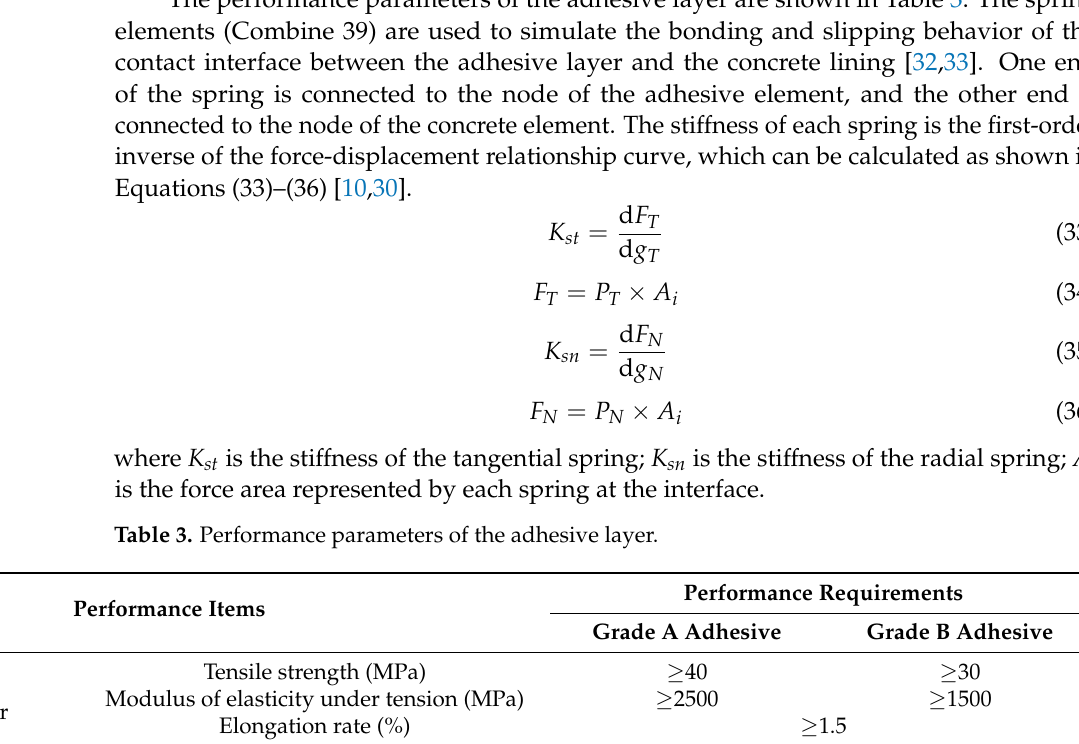
Table 3. Performance parameters of the adhesive layer.